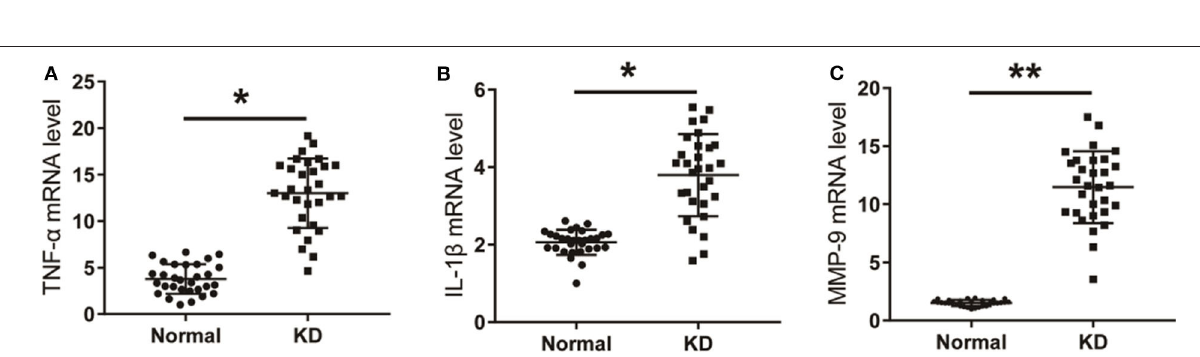
FIGURE 3 | The level of 14, 15-EET in KD patients and control children. (A) ELISA was performed to detect 14, 15-EET level in patients with KD and normal control group. (B) The level of 14, 15-EET in KD patients with CAL or nCAL. * P < 0.05; ** P < 0.01.